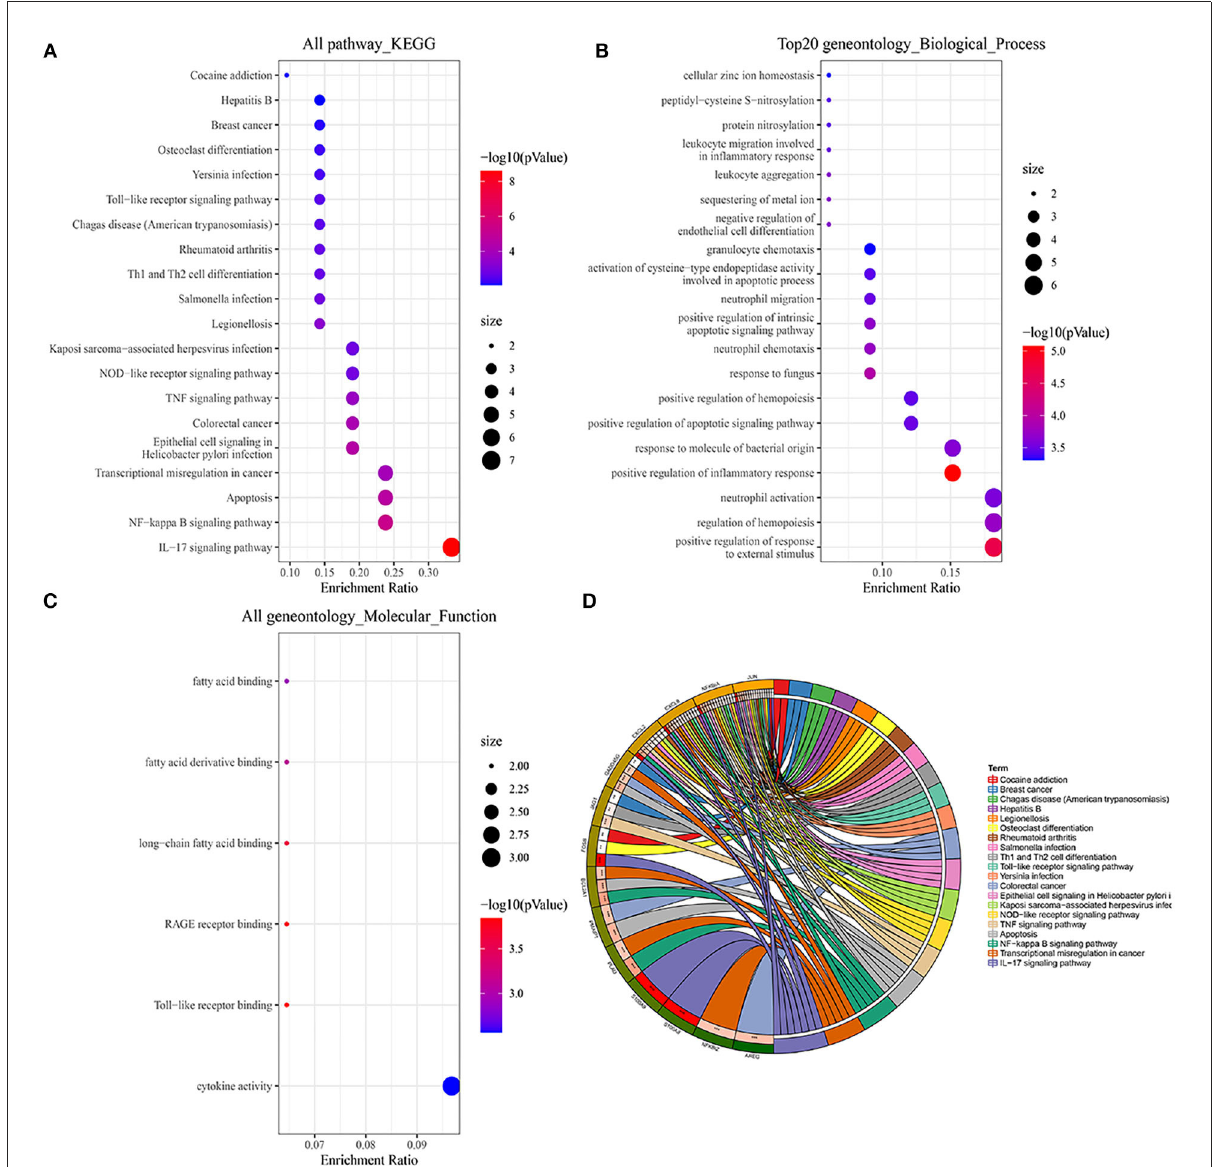
FIGURE2 GO and KEGG pathway enrichment analysis of DEGs. (A,D) Bubble charts and chord plots both show KEGG pathway enrichment significance items of DEGs. (B,C) Two Bubble charts show GO enrichment significance items of DEGs in the two sections of BP and MF. In the Bubble charts, the Y-axis label represents enrichment significance terms and the X-axis label represents the gene ratio. In the Chord plot, DEGs are exhibited on the left side of the graph, and enrichment significance items are exhibited on the right side of the graph.